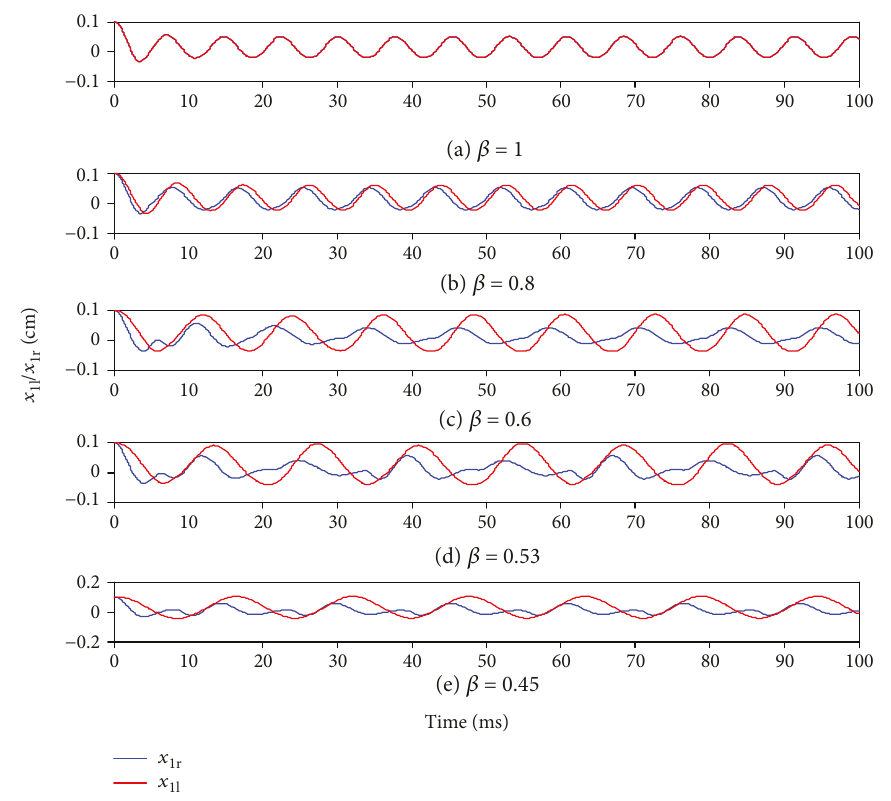
Figure 3: Mass displacements of the lower left and right sides.